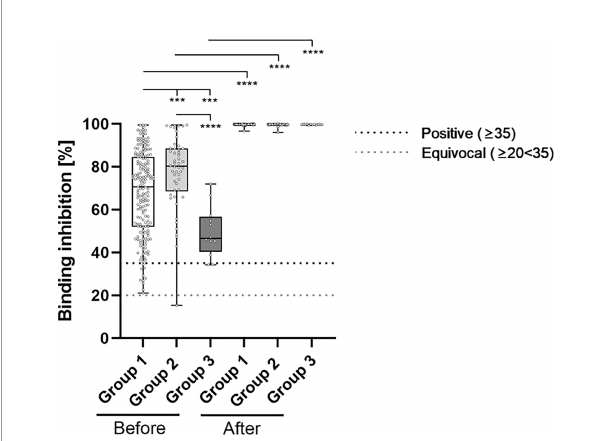
FIGURE 3 | Comparative determination of neutralizingantibodybinding- inhibition-capability before andafter thirdbooster vaccination with BNT162b2. To evaluate differences between vaccination-strategies, participants were grouped into 3 cohorts: Group 1: three vaccine-doses of BNT162b2; Group 2: initially two vaccine-doses of ChAdOx1 and BNT162b2 booster-dosage; Group 3: heterologous vaccination-protocol(ChAdOx1+ BNT162b2) andBNT162b2 booster-dosage. Binding inhibition capability of neutralizinganti-SARS-CoV-2 antibodies was determined using the NeutraLISA ™ SARS-CoV-2 Neutralization Antibody Detection KIT fromEuroimmun.According to the manufacturer,binding inhibition values above orequalto 35% were considered positive (horizontal black dottedline), whereas values between 20% and 35% were considered equivocal (horizontal gray dotted line).***p < 0.001; ****p < 0.0001 (Mann-Whitney U-test).